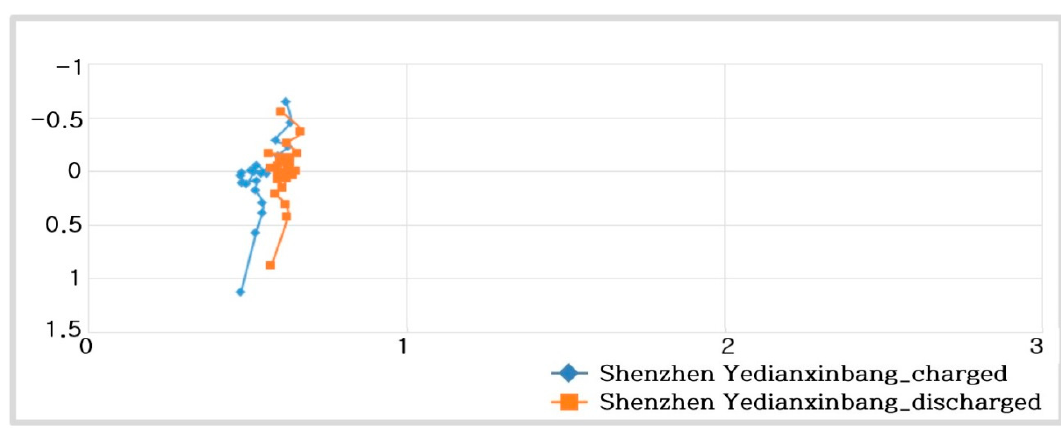
Figure 23. Impedance spectra of pouch-type Li-ion batteries.